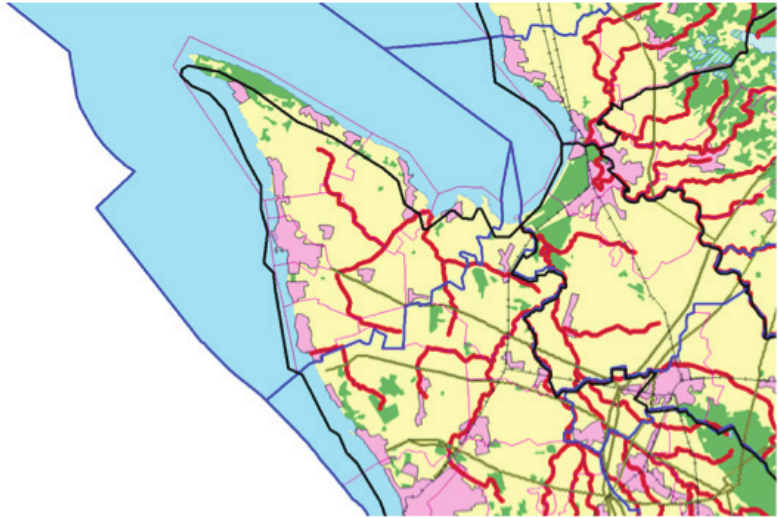
Figure 1: The shore line (black) in the foreground does not follow the shoreline in the background data: geometric conflicts cause the maps to be